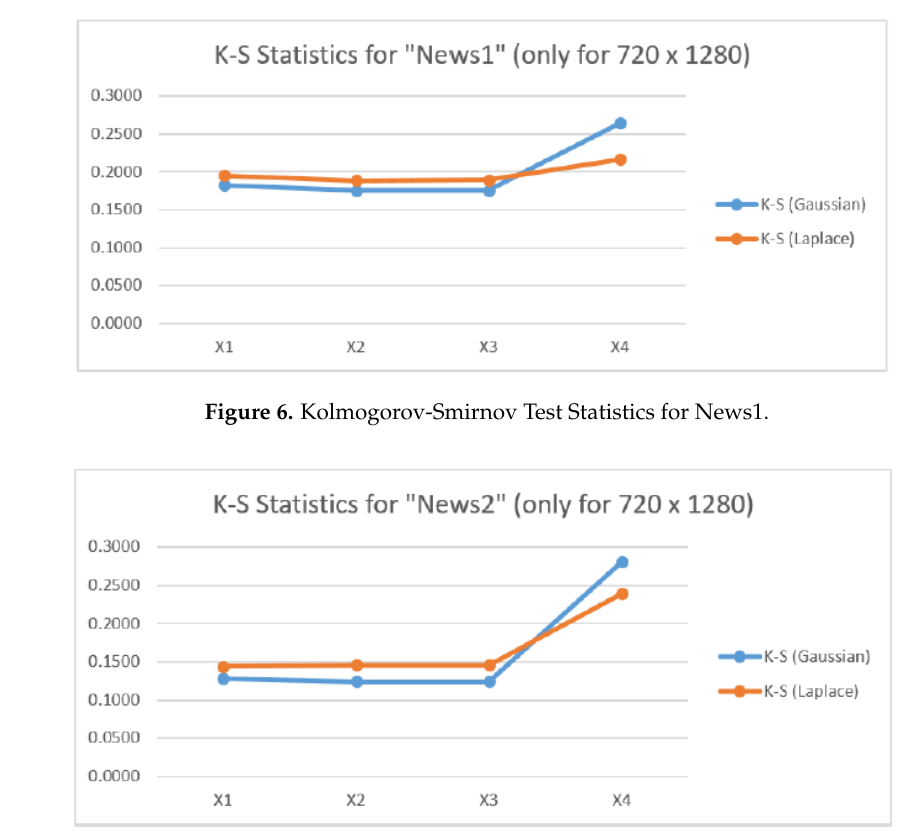
Figure 7. Kolmogorov-Smirnov Test Statistics for